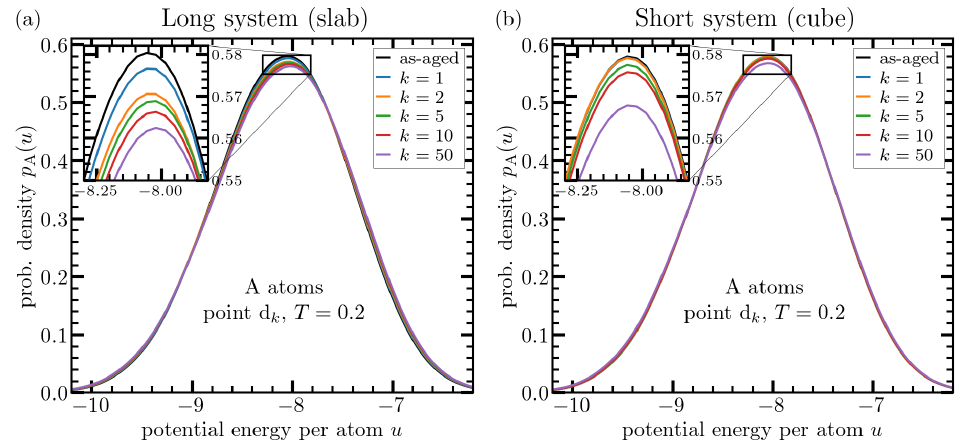
Figure 4. Effect of deep thermal cycling on probability distribution for energy per particle for A-type, evaluated at point d k . Panel ( a ) shows the data for a system with a linear dimension of L slab = 2000 particle diameters (slab geometry) and panel ( b ) depicts the same type of data for a cubic system with L cube = 128. Different curves correspond to different number of thermal cycles as indicated in the legends. Prior to data analysis, thermal cycling is stopped at point d k and the system is relaxed for a duration of 10 4 t LJ at T = T i = 0.2. This serves to damp pressure waves, which are produced due to thermally-induced expansion and contraction. Even though somewhat difficult on this scale, a broadening of energy distribution can be seen in panel ( a ) (see also Figure 7) indicating increased heterogeneity due to thermal cycling, i.e., rejuvenation. The inset serves to highlight the shift in mean energy toward higher values upon thermal cycling. This shift is much smaller in the right panel